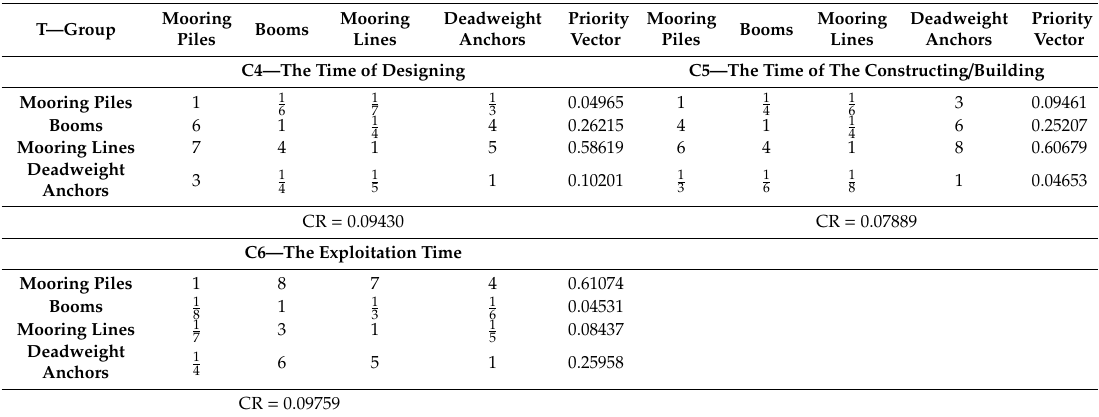
Table 9. Comparison matrix alternative for Time criteria group.